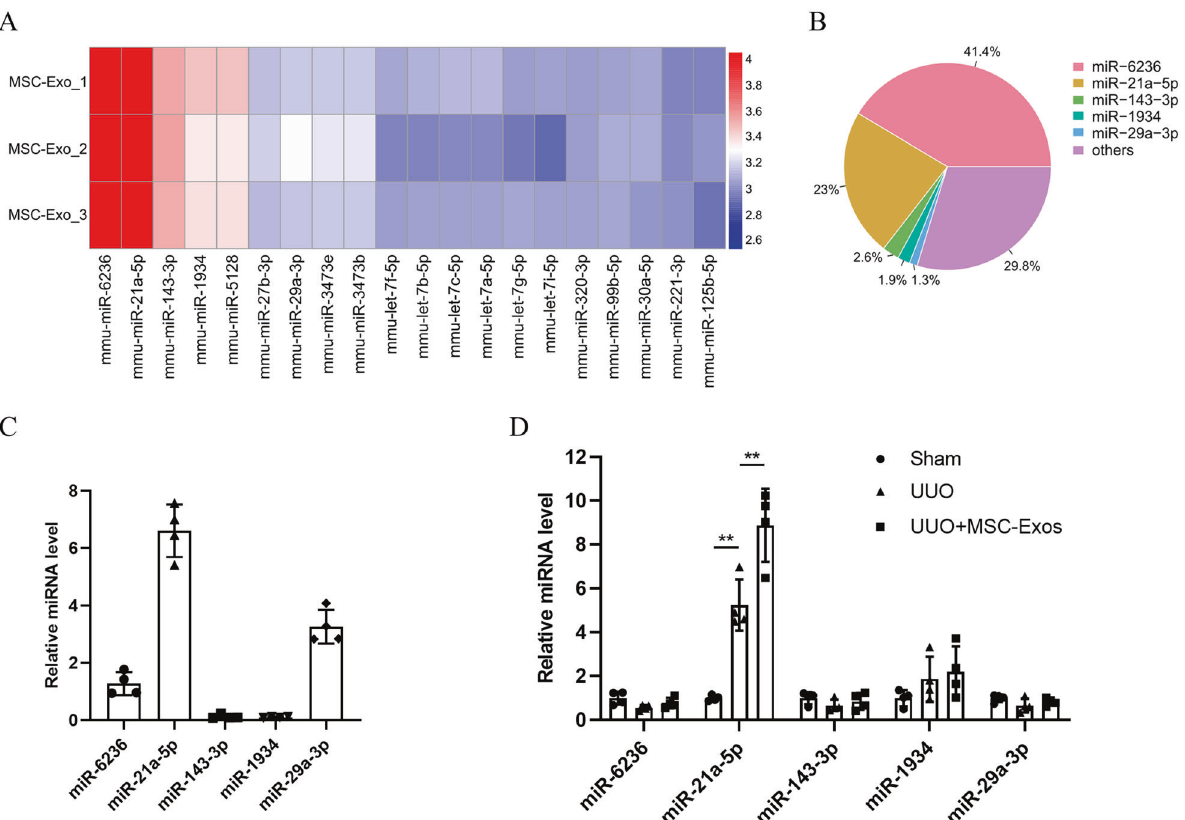
Fig. 4 miR-21a-5p is enriched in MSC-Exos. A Exosomal miRNA sequencing revealed the top 20 most abundant miRNAs in MSC-Exos. B Relative percentages of different miRNAs in total miRNA reads. C qPCR analysis of the top 5 miRNAs in MSC-Exos ( n = 4). D Relative expression of the top 5 miRNAs in MSC-Exos in kidney tissues from sham, UUO and MSC-Exo-treated mice ( n = 4 mice per group). Data are presented as the mean ± SD from three independent experiments. ** p <